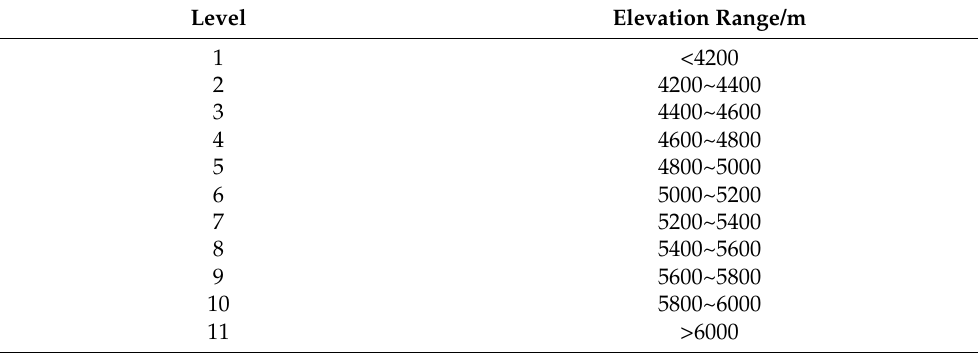
Table 2. Elevation classification.